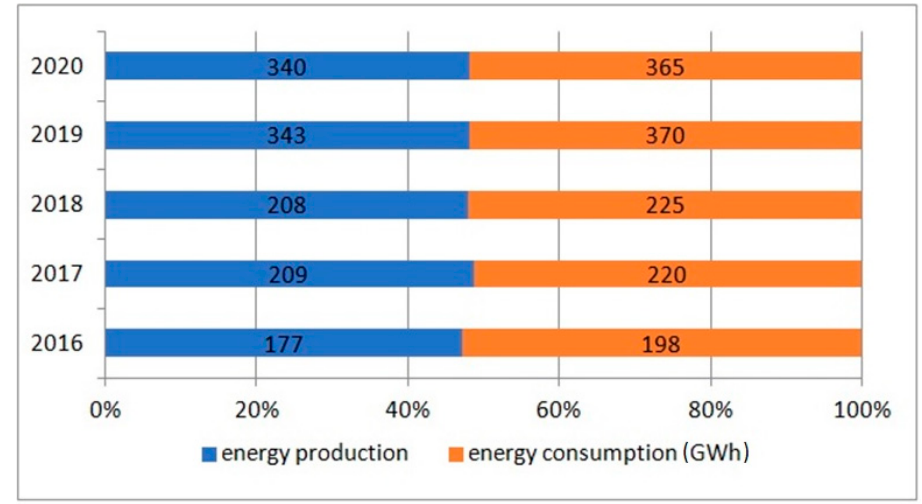
Figure 16. Energy production in small RES installations in 2016–2020 (GWh) [61].